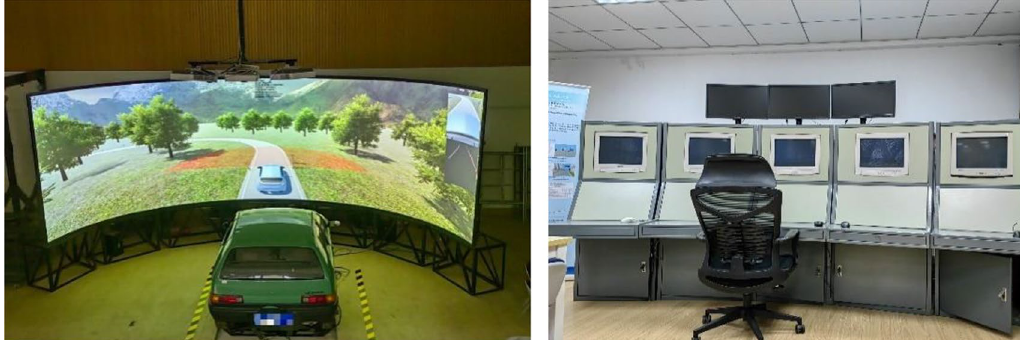
Figure 1. KMRTDS driving simulation system.